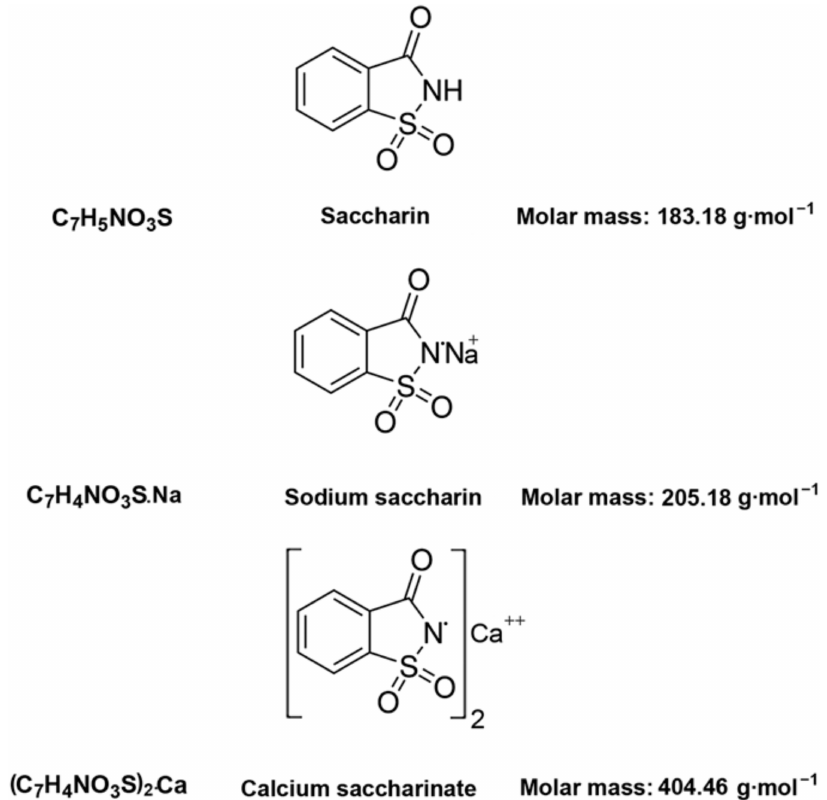
Figure 1. Structural and molecular formulas and relative molecular mass of saccharin and its